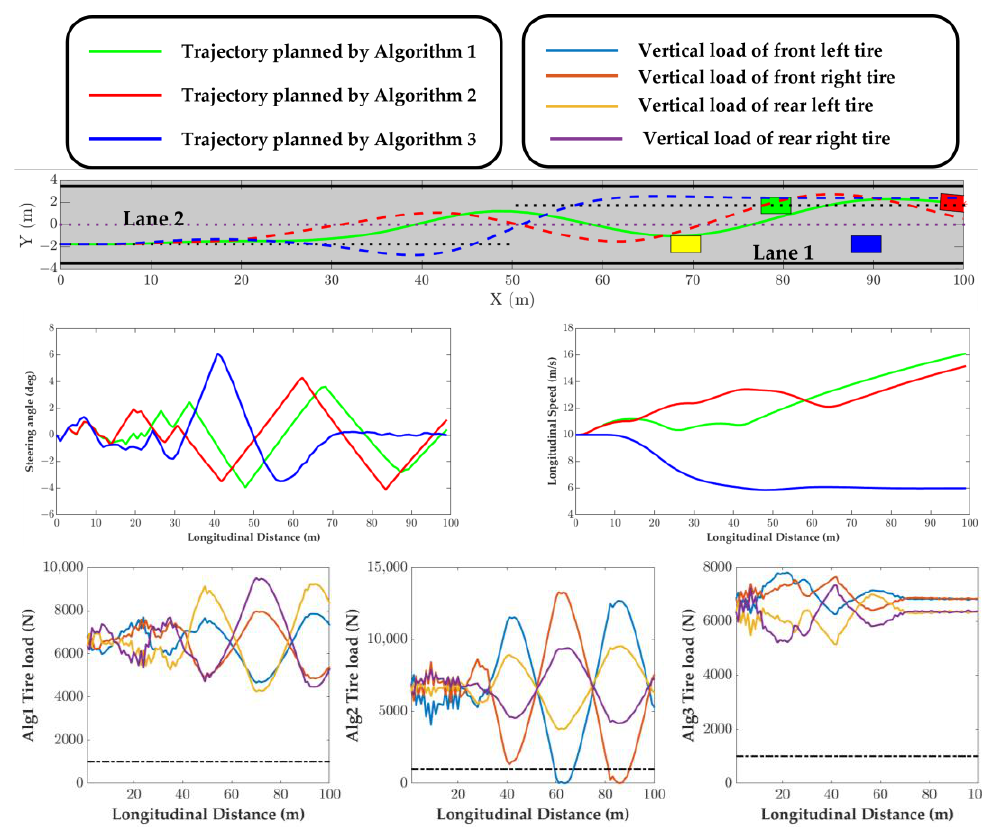
Figure 6. The sketch of the scenario in Experiment 3.